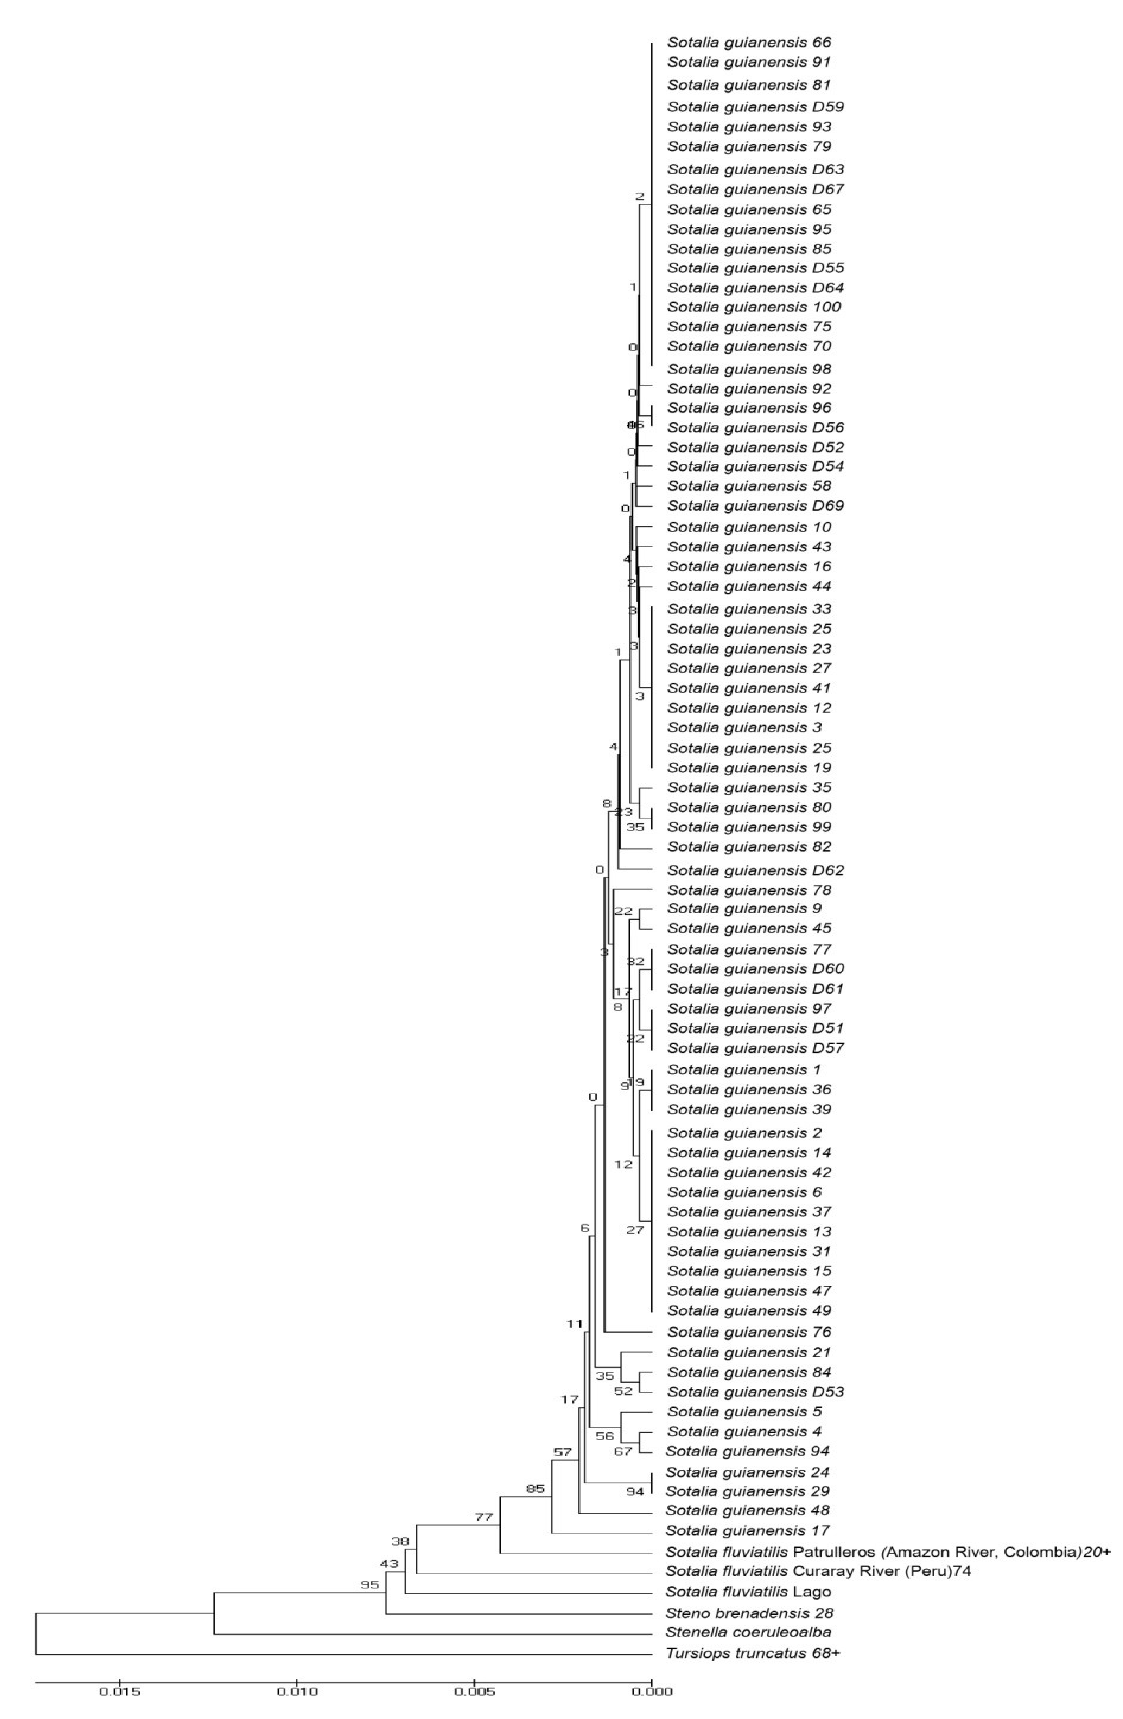
Figure 3. Maximum likelihood tree at the mitochondrial control region gene for Sotalia guianensis , Sotalia fluviatilis , Steno brenadensis , Stenella coeruleoalba and Tursiops truncatus